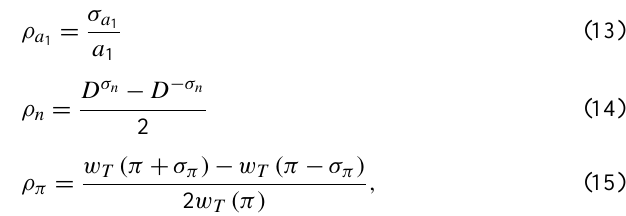
ratio between SDV and mean (i.e. the coefficient of varia- tion) of each estimated parameter, except ξ : for this parame- ter, which has values around zero, the ratio between the SDV and the maximum of the absolute value of the mean is shown.